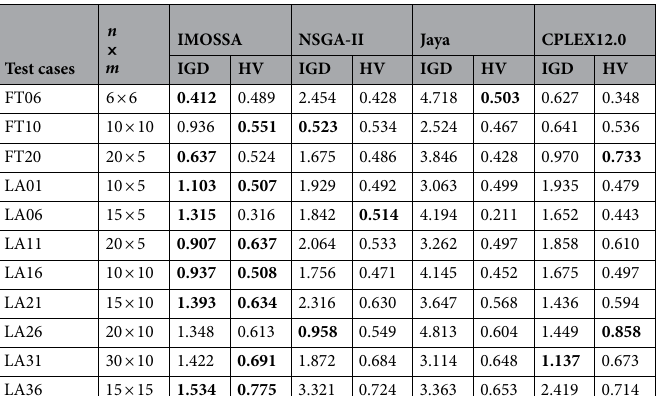
Table 7. Comparison of the performance measure results of three algorithms. Significant values are in bold.